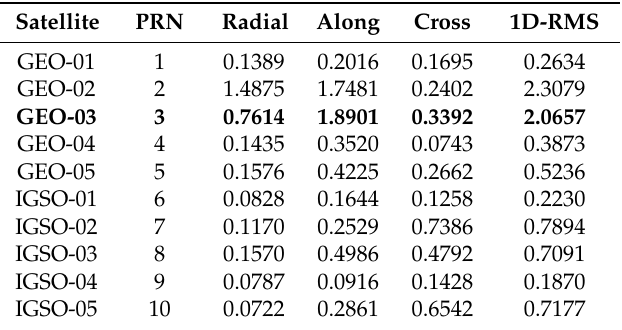
Figure 14. Comparison Strategy of GEO-03. Table 5. RMS of orbit overlap comparison at 5 January (unit: m).